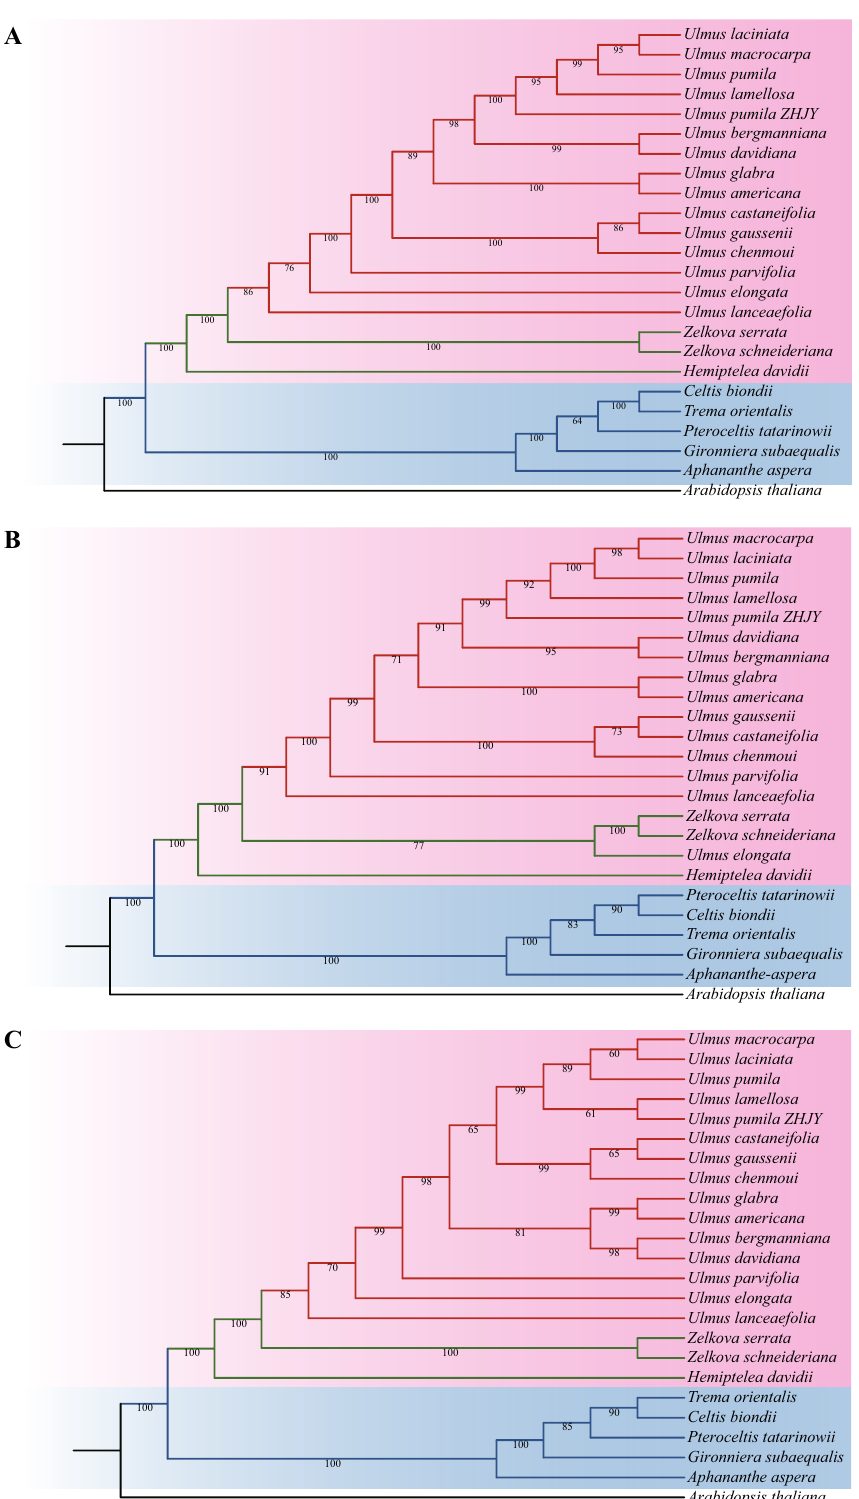
Figure 10. Phylogenetic trees of 23 Ulmaceae species. ( A ) Phylogenetic tree constructed using common protein coding genes; ( B ) Phylogenetic tree constructed using the whole cp genome; ( C ) Phylogenetic tree constructed using common genes in IR